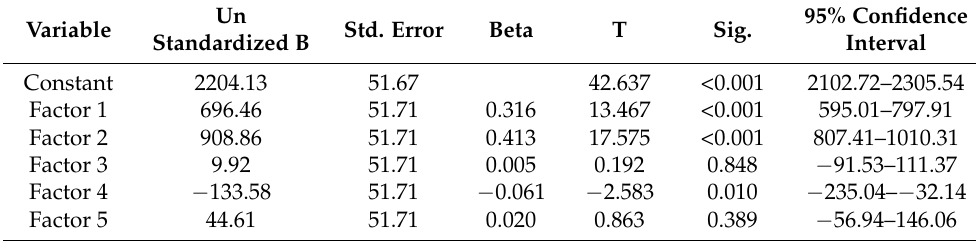
Table 4. Linear Regression model for rate of COPD hospitalizations.